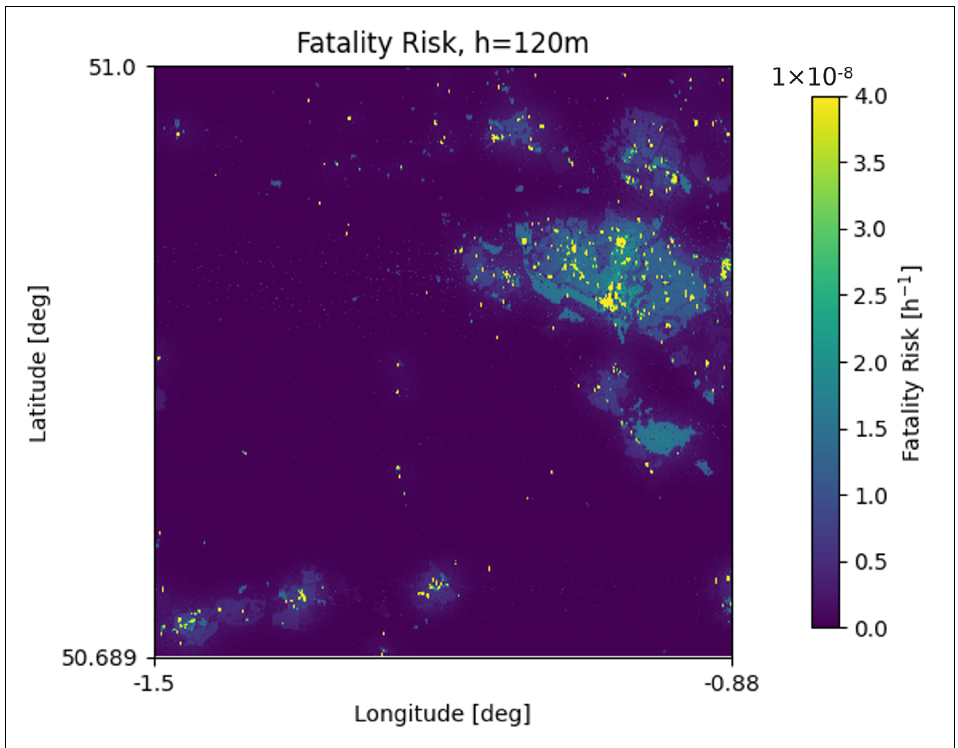
Figure 2. Fatality Risk Map of the Southampton and New Forest area for the Mugin 5 Pro drone flying at a height of 120